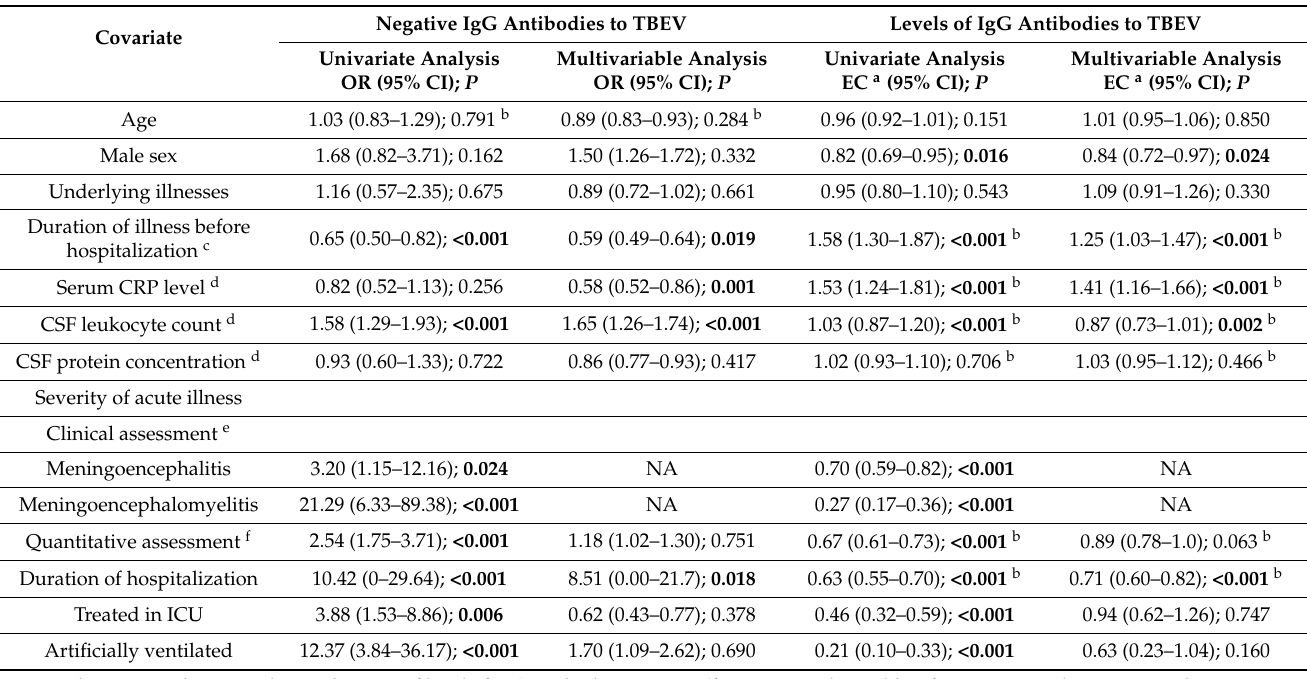
Table 2. Covariates representing acute illness associated with the negative IgG antibodies/levels of IgG antibodies to tick-borne encephalitis virus in the serum of patients early during the meningoencephalitic phase of tick-borne